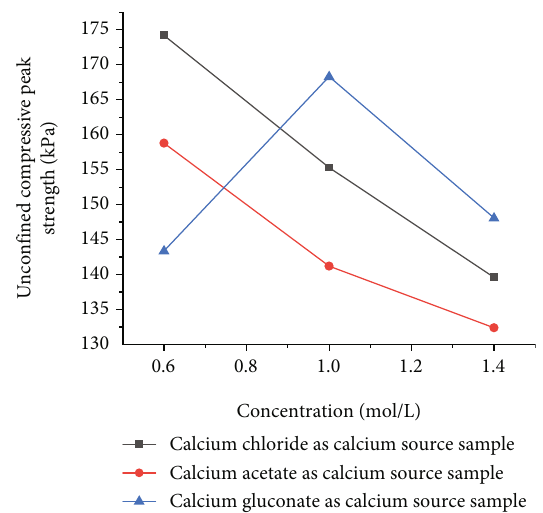
Figure 11: Uncon fi ned peak intensity curves of samples with di ff erent calcium sources and